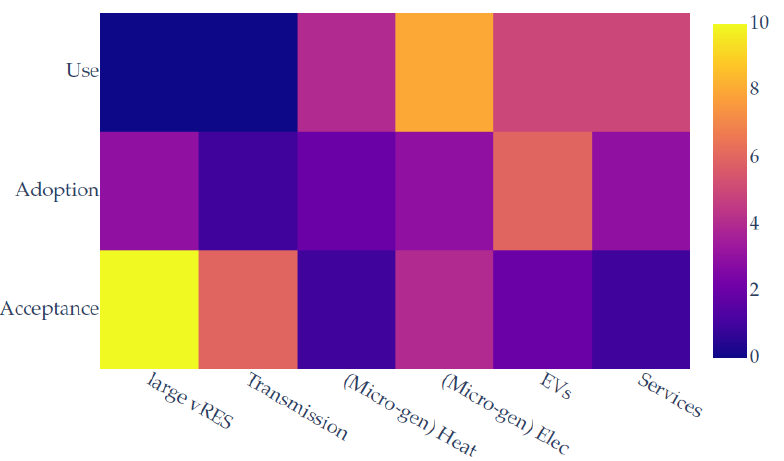
Figure 5. Findings in the intersection of behavioural aspects and technologies or services considered.